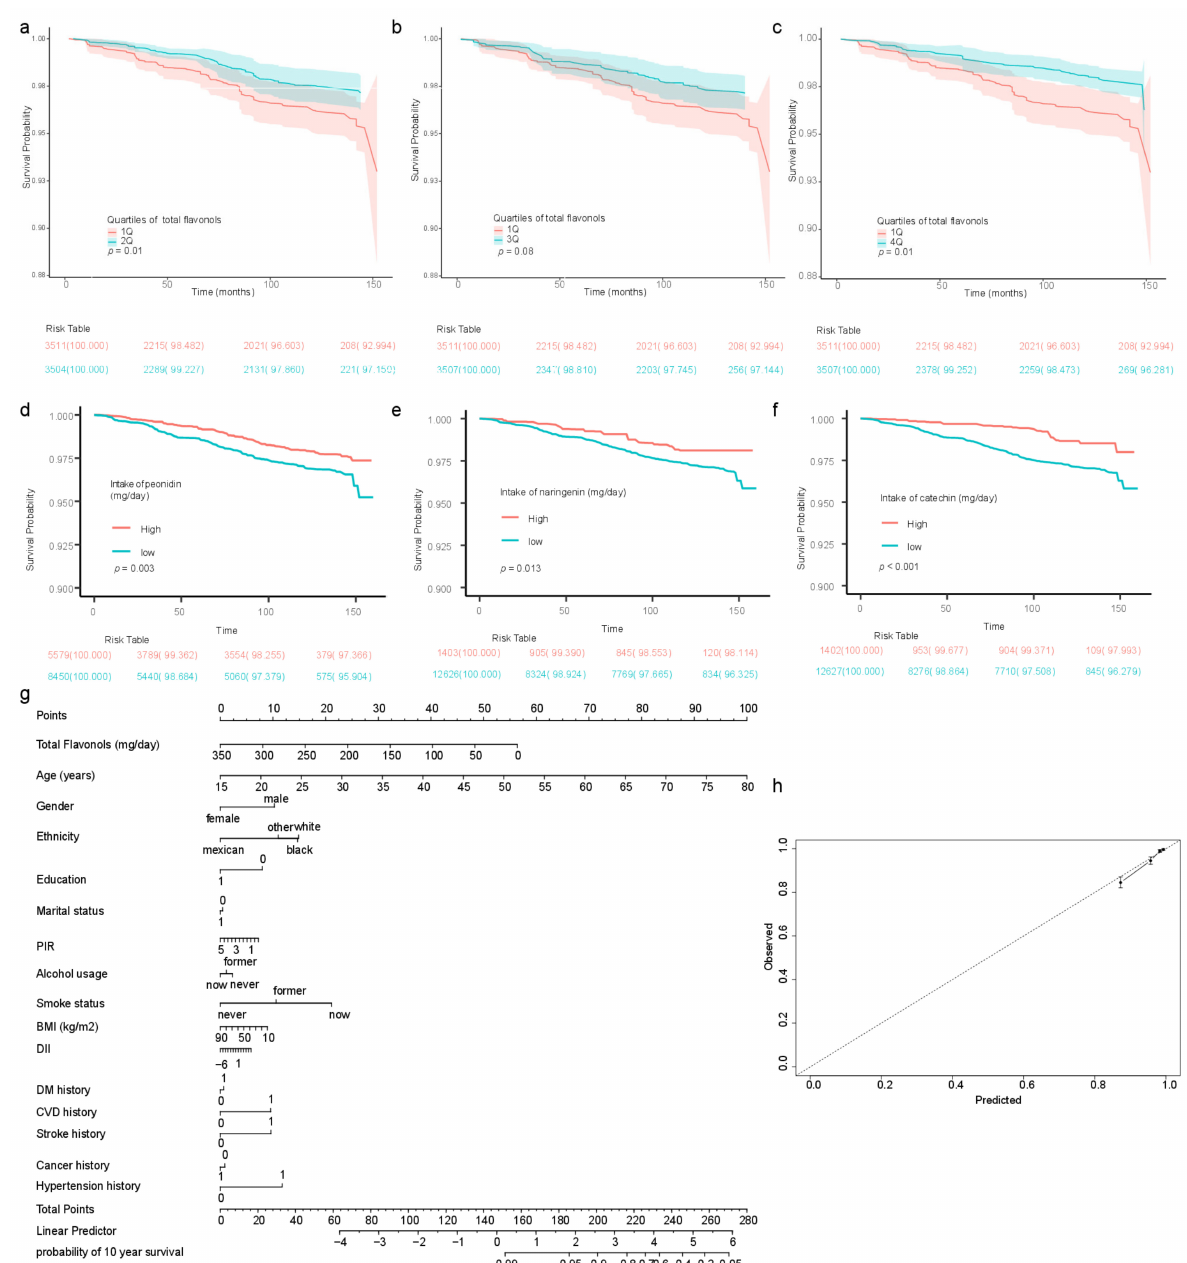
Figure 3. The survival curves of participants and the related nomogram. Comparison of survival probabilities for participants with dietary flavonol intake in the first quartile and second quartile ( a ); in the first quartile and third quartile ( b ); in the first quartile and fourth quartile ( c ). Kaplan–Meier analyses of survival probabilities based on the 60th percentage value of dietary peonidin intake ( d ). Kaplan–Meier analyses of survival probabilities based on the 90th percentage value of dietary naringenin intake ( e ). Kaplan–Meier analyses of survival probabilities based on the 90th percentage value of dietary catechin intake ( f ). Nomogram established with a total dietary intake of flavonols ( g ). Calibration curve to assess the consistency of the predicted survival possibility at ten years via the nomogram with total dietary flavonol intake ( h ). BMI: body mass index; COPD: chronic obstructive pulmonary disease; DM: type 2 diabetes mellitus. Regarding the disease prevalence, 0 indicates “no” and 1 indicates “yes”. Participants with less than 12 years of education were coded as 0; those with 12 years of education or above were coded as 1. As for marital status, participants with a partner were coded as 1; participants without a partner were coded as 0. PIR: poverty income